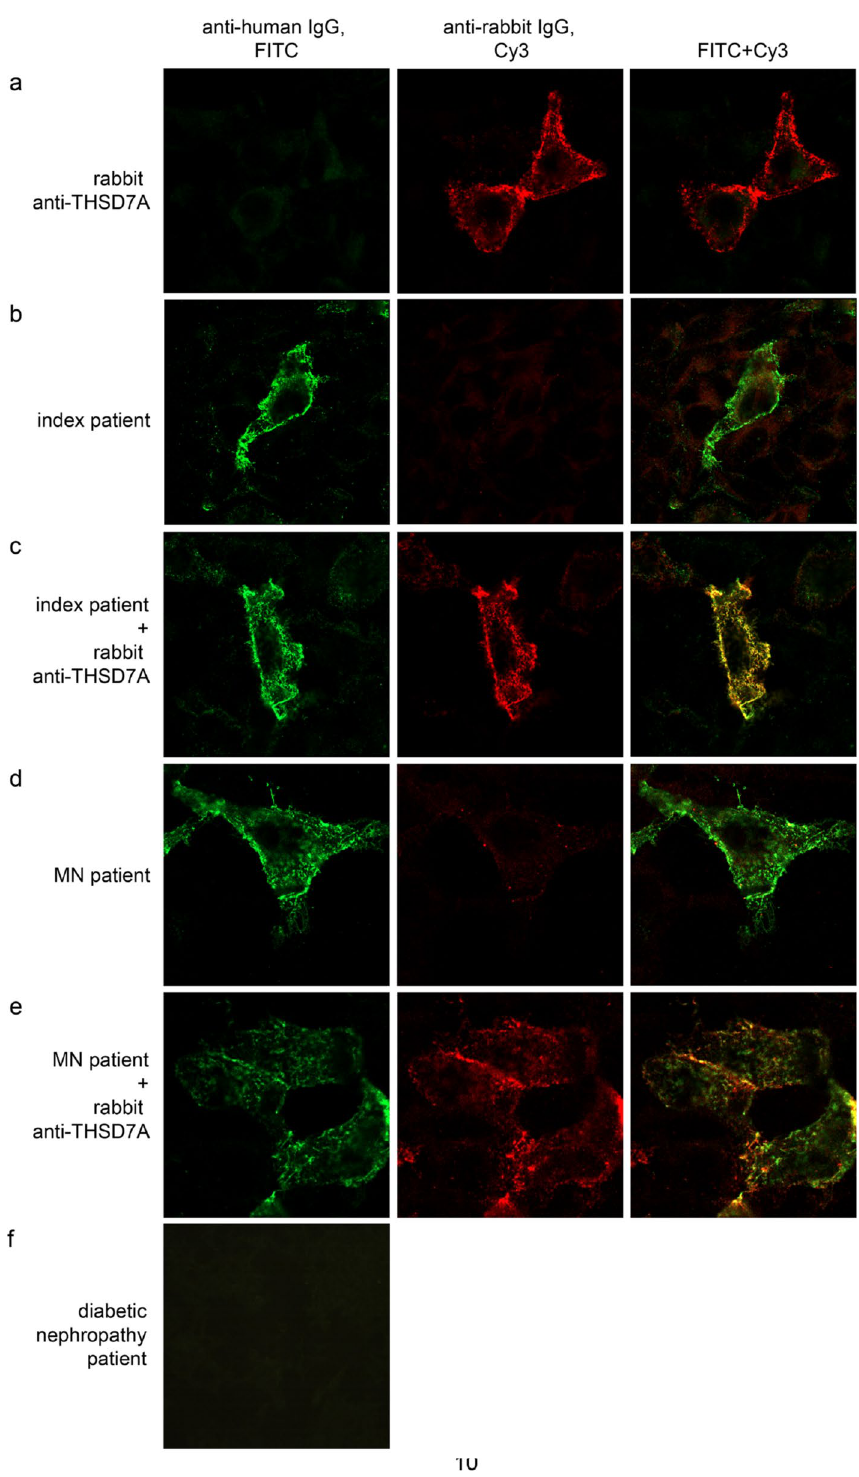
Figure 3. Immunofluorescence co-staining. Representative photographs of THSD7A-expressing HEK cells co-stained with FITC-coupled anti-human IgG (in green) and Cy3-coupled anti-rabbit IgG (in red). ( a – e ): as primary antibody the following was used: ( a ) a commercial rabbit anti-THSD7A; ( b ) serum from the presented patient case; ( c ) a combination of rabbit anti- THSD7A with serum from the patient case; ( d ) serum from a patient with THSD7A-associated MN and ( e ) a combination of rabbit anti-THSD7A with serum from a patient with THSD7A-associated MN. Co-staining experiments reveal that serum of the patient case ( c ) and a patient with THSD7A-associated MN ( e ) co-localize with the THSD7A-specific rabbit antibody, showing that both sera specifically recognize THSD7A on the THSD7A-expressing HEK cells. ( f ) Representative photograph of THSD7A-expressing HEK cells assayed with serum from a patient with diabetic nephropathy but no membranous nephropathy and visualized with FITC-coupled anti-human